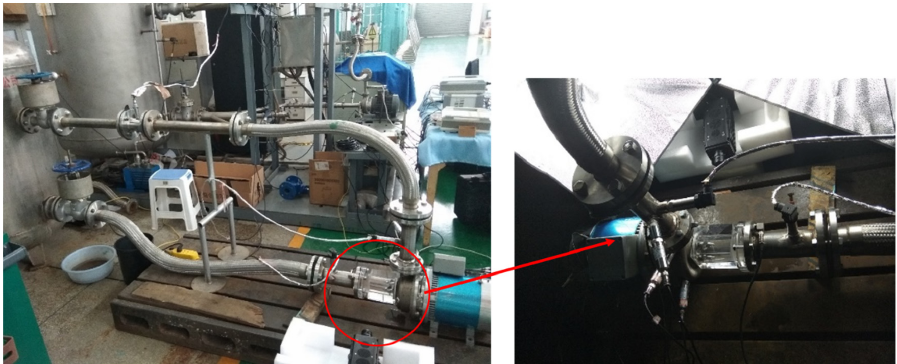
Figure 4. Visual test